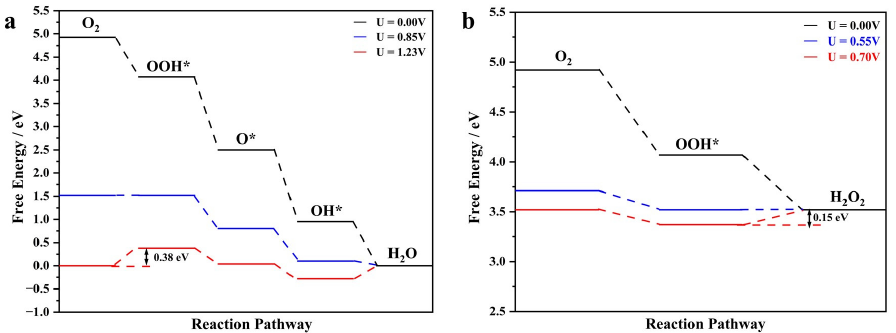
Figure 4. Free energy changes in the ( a ) 4e − ORR and ( b ) 2e − ORR on Pt 1 @GDY with different volt- ages.